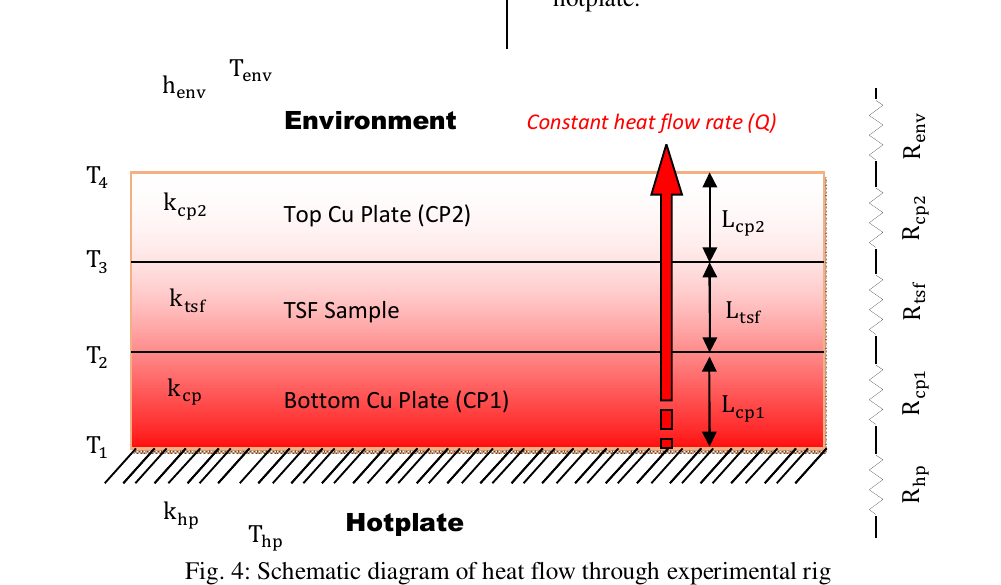
Fig. 4: Schematic diagram of heat flow through experimental